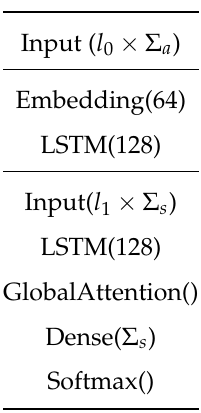
Figure 8. Implementation scheme of the Seq2Seq-Attn approach, where l n represents the sample length, Σ a the size of the agnostic vocabulary and Σ s is the size of the semantic